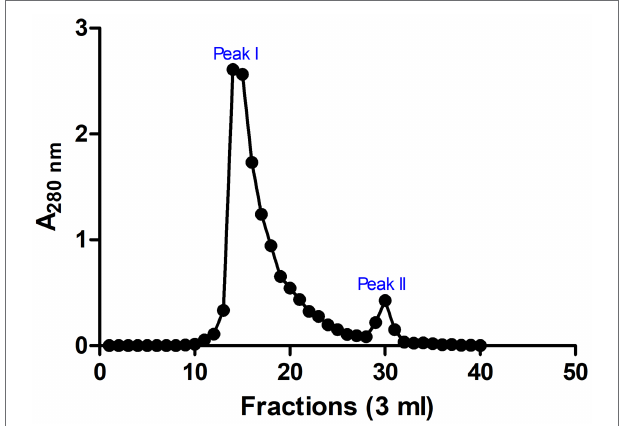
FIGURE 3 | Chromatogram for fractions of gel filtration chromatography. Sephadex G-25 chromatographic resin was used and two prominent peaks (peaks I and II) were observed. Absorbance was measured at 280 nm. The image was rendered in GraphPad 5.0 statistical package.